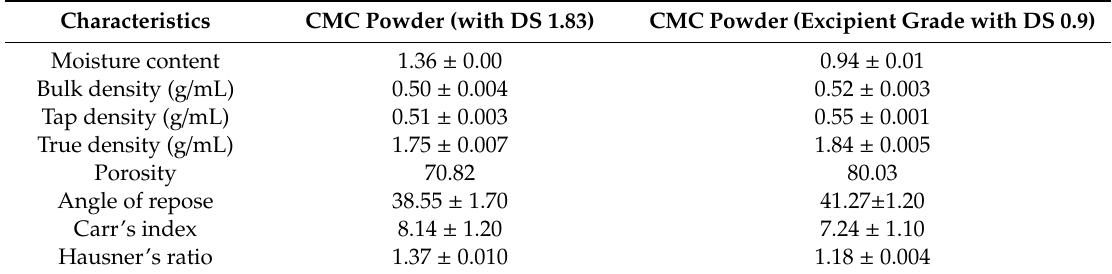
Table 2. Physicochemical characteristics of synthesized CMC as an